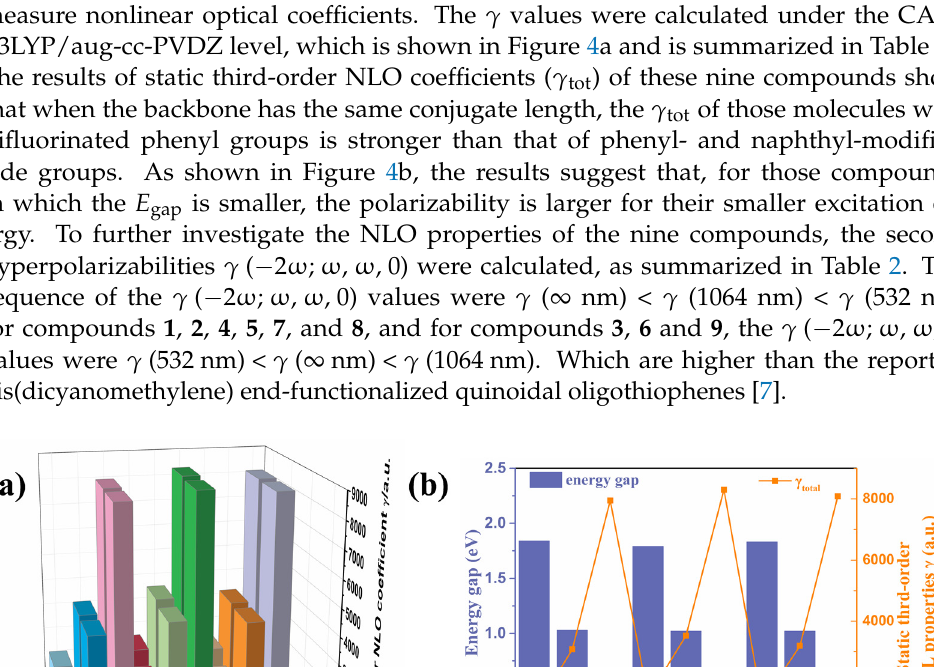
Figure 4. ( a ) Static third-order NLO coefficients ( γ ) of the compounds ( 1 – 9 ); ( b ) the relationship between the static third-order NLO polarizabilities and E gap .